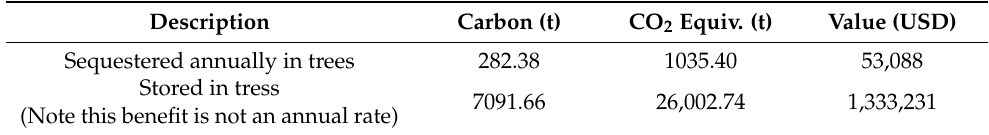
Table 4. Tree benefits estimation: carbon sequestration.